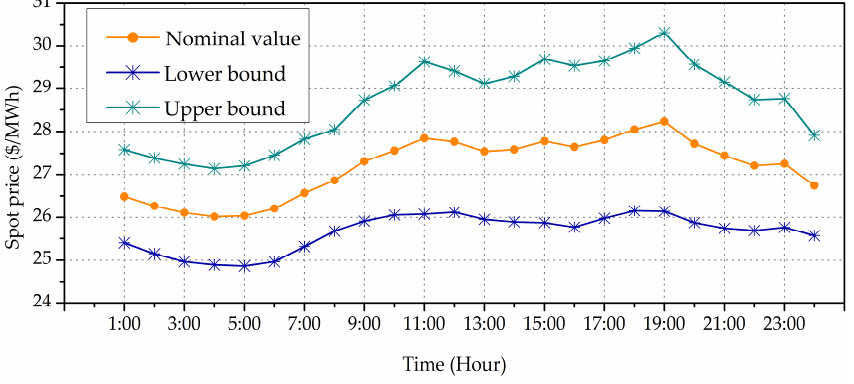
Figure 2. Lower, upper and nominal values of spot prices.